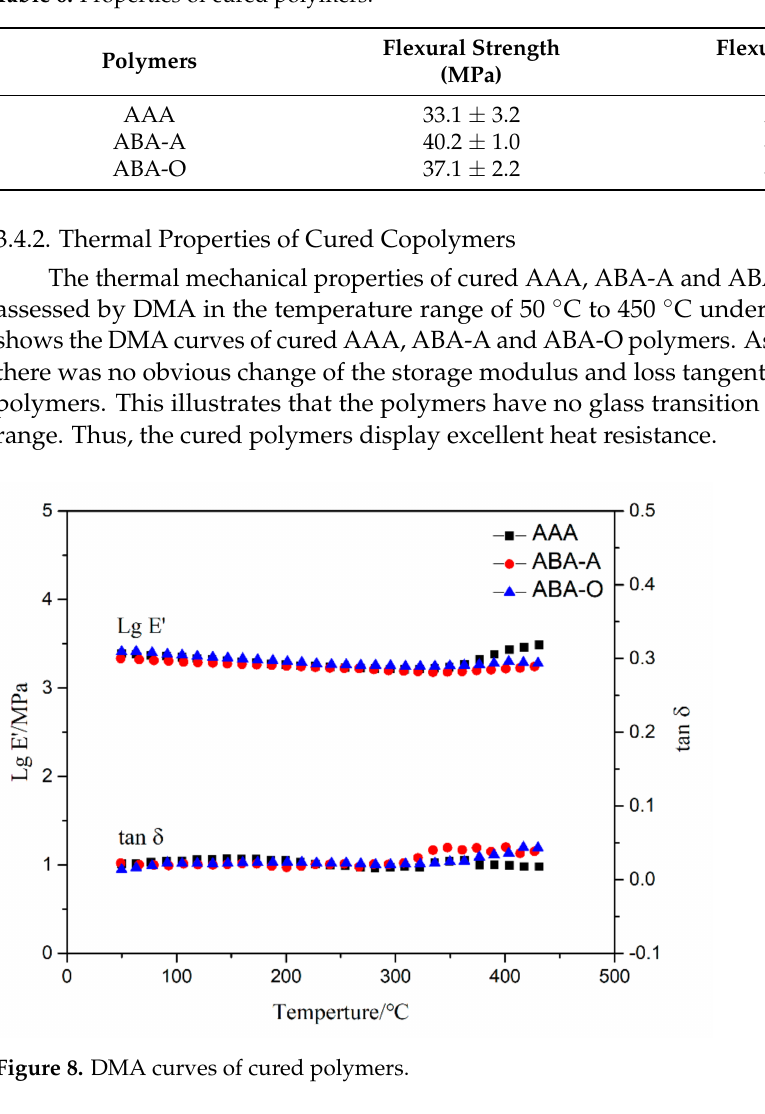
Table 6. Properties of cured polymers.